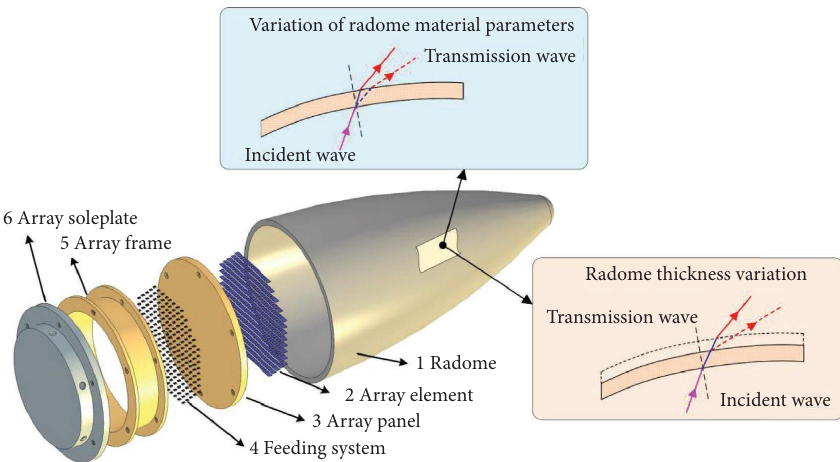
Figure 8: Schematic diagram of infuence of material parameters and thickness changes of radome